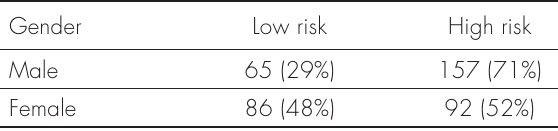
Table II. Association between gender and risk category.